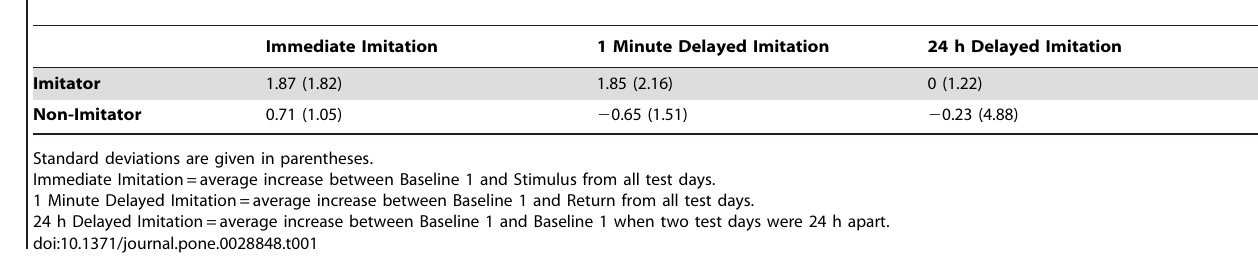
Table 1. Average increase of LPS responses for a subset of imitators (N =18) and non-imitators (N